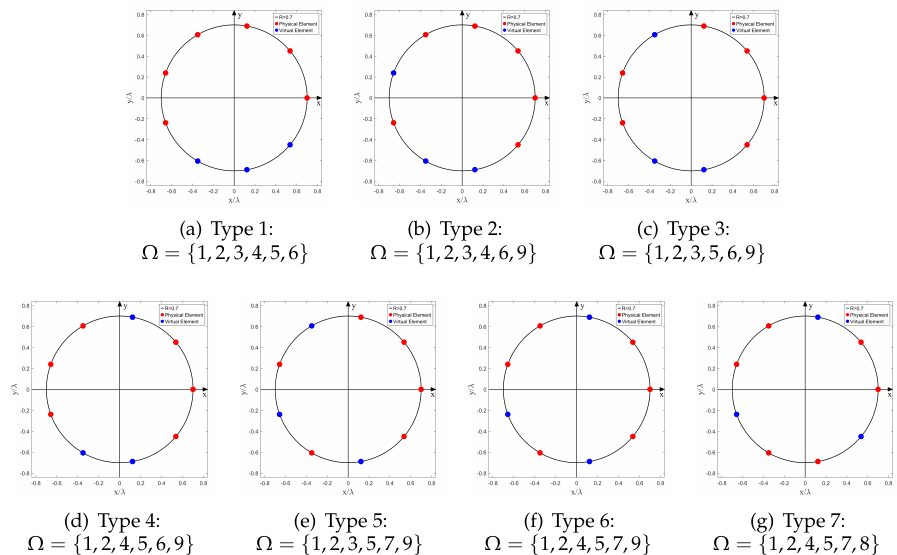
Figure 4. Different Array Configurations, ( N = 9, N p = 6).